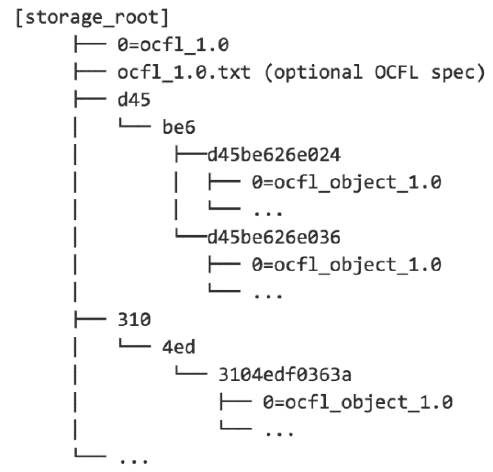
Figure 3. An example of a Truncated n-tuple tree OCFL Storage Hierarchy.